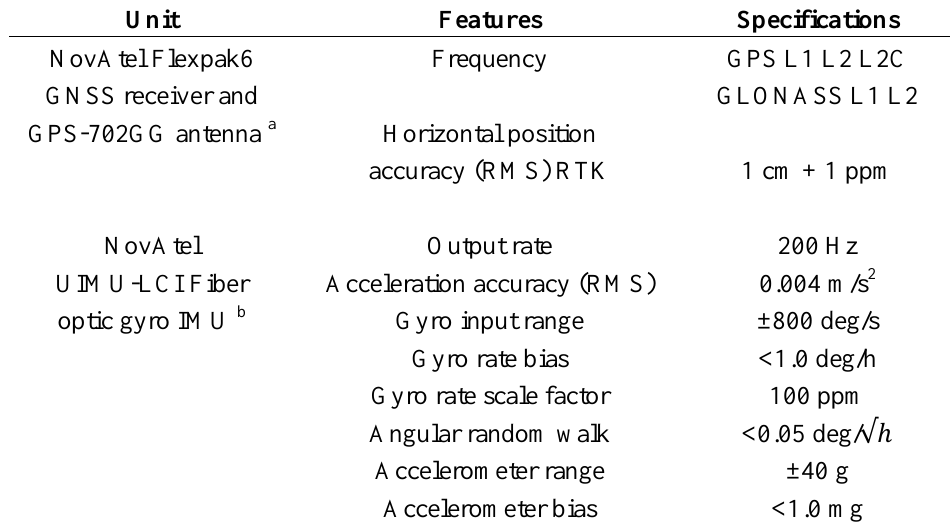
Table 1. Specifications of the navigation system (NovAtel SPAN GNSS-IMU).